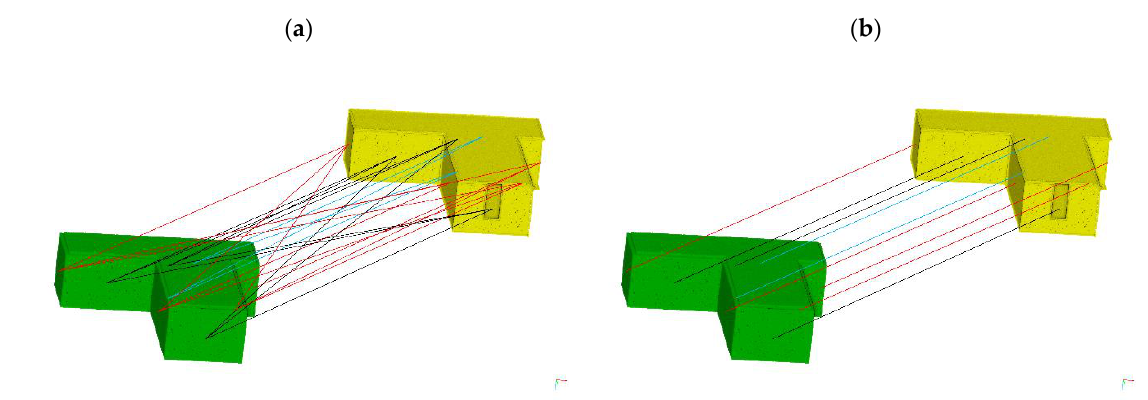
Figure 9. Representation of all the possible translation vectors t i , j , are shown with line colors indicating the parallel plane segments from the ( a ) potential matching planes and ( b ) matching planes.